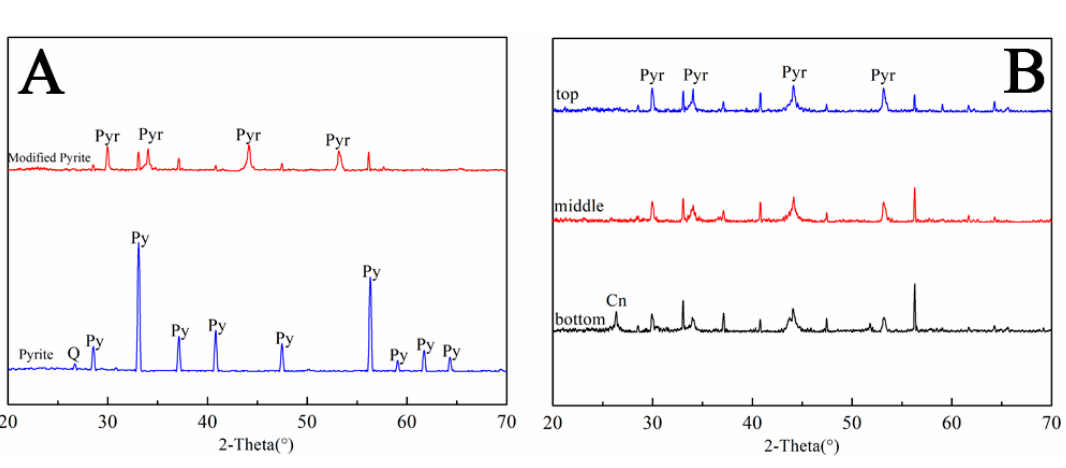
Figure 2. XRD patterns of the ( A ) fillers of the two columns before the experiments (Py: pyrite; Pyr: pyrrhotite; Q: quartz) and ( B ) three samples at the bottom, middle and top of the MPy column (Pyr: pyrrhotite; Cn: cinnabar).